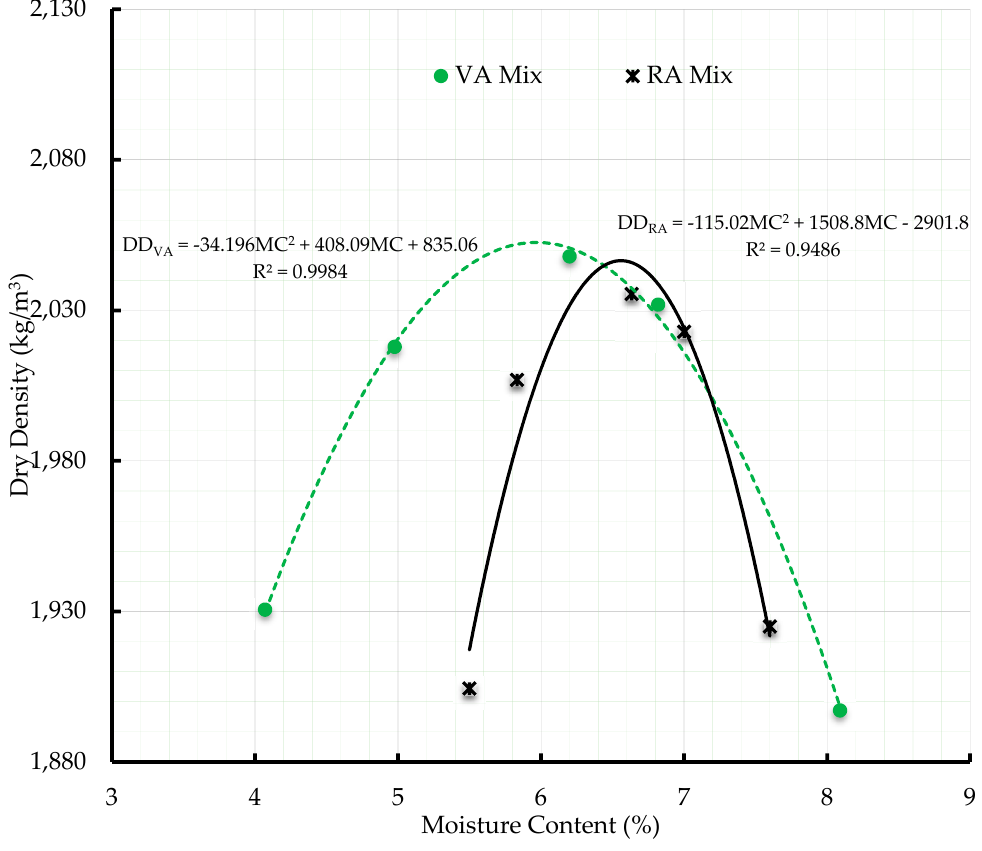
Figure 2. Maximum Dry Density and Optimum Moisture Content for Virgin Aggregates and Reclaimed Asphalt Aggregates Mixes.